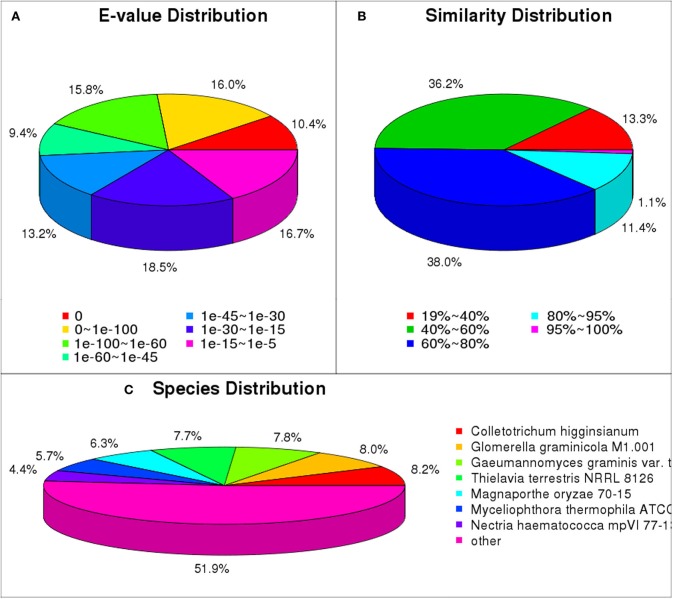
NR classification of P. liquidambari unigenes. (A)
E-value distribution. (B) Identity distribution. (C) Species distribution.